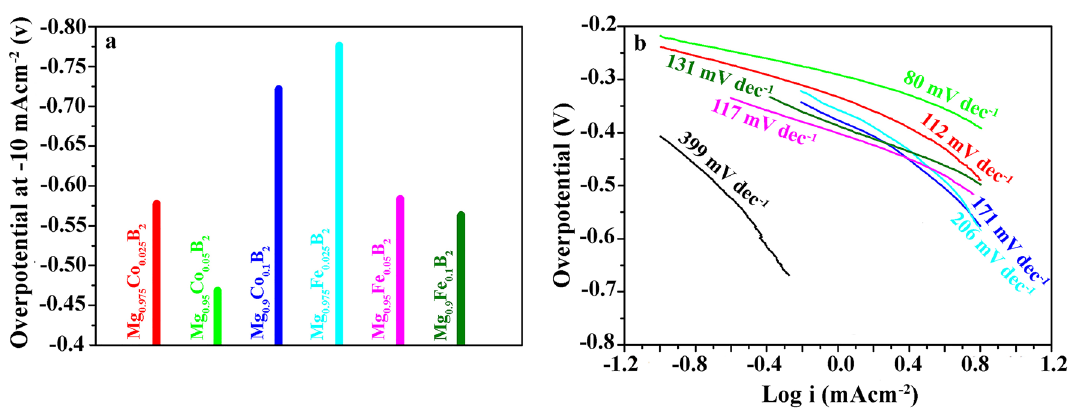
Figure 8. Fundamental electrochemical properties for HER. ( a ) Overpotential at − 10 mA cm − 2 of metal-doped MgB 2 , ( b ) the corresponding Tafel plots of undoped and doped MgB 2 . The colors indicating the same samples pictured in Fig.